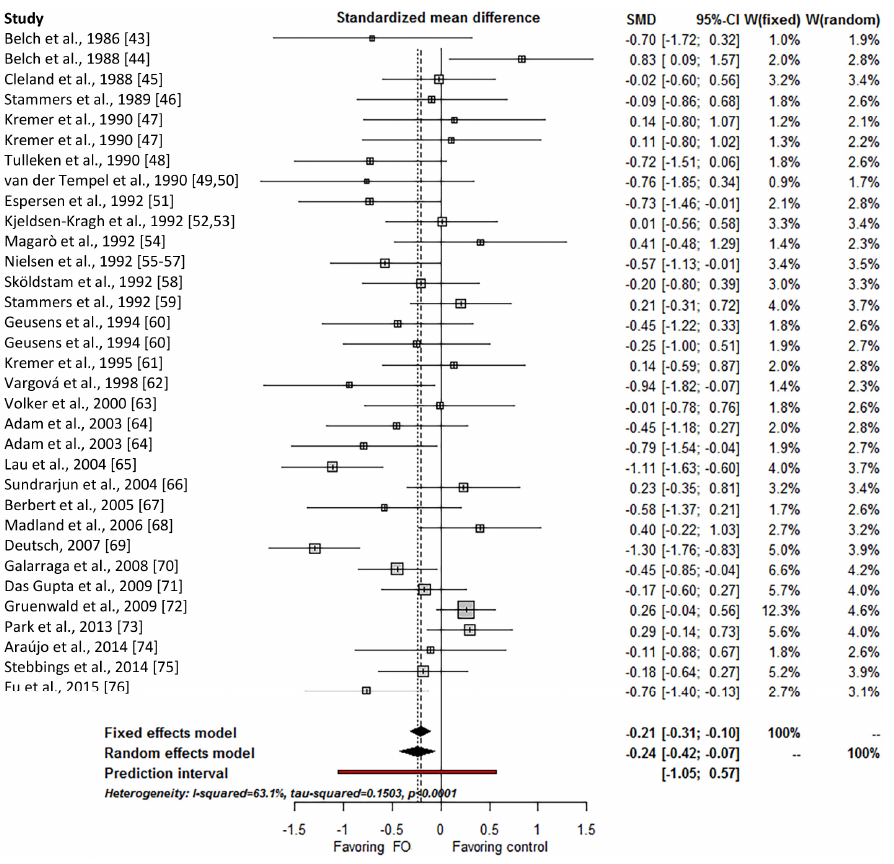
Figure 3. Forest plot of the effect size for marine oil interventions on pain. Weights are shown for both a random ‐ effects model (“W(random)”) and a fixed ‐ effects model (“W(fixed)”). 95% CI: 95% confidence interval; MO: marine oil; SMD: standardized mean differences. Note that the use of the term MO refers to all oils of marine origin (e.g., oil from whole fish and mussel oil). Meta ‐ regression analyses (Table 2), showed that a statistically significant amount of the heterogeneity could be explained by type of diagnosis ( p = 0.024), supplementation type ( p = 0.009), dosage of EPA plus DHA ( p = 0.016), and ratio of EPA/DHA ( p = 0.031), but not by type of control ( p = 0.051) or duration ( p = 0.074). There was a significant effect in patients with RA (22 trials; SMD − 0.21; 95% CI, − 0.42 to − 0.00) and other/mixed diagnoses (3 trials; SMD − 0.63; 95% CI, − 1.20 to − 0.06), but no effect in patients with OA (5 trials; SMD − 0.17; 95% CI, − 0.57–0.24). All bias domains, except blinding of personnel and blinding of outcome assessors, could also explain a significant amount of the heterogeneity. Post hoc meta ‐ regression analyses for RA separately are provided in Table S5. A significant positive association was found between SMD and total dose of EPA and DHA (slope β , 0.13 (g/day) − 1 , 95% CI, 0.04–0.22, p = 0.006), indicating less effect at higher dose, but there was no duration ‐ response relationship ( p = 0.568). Plots of the meta ‐ regression analyses are provided in Figure S1.